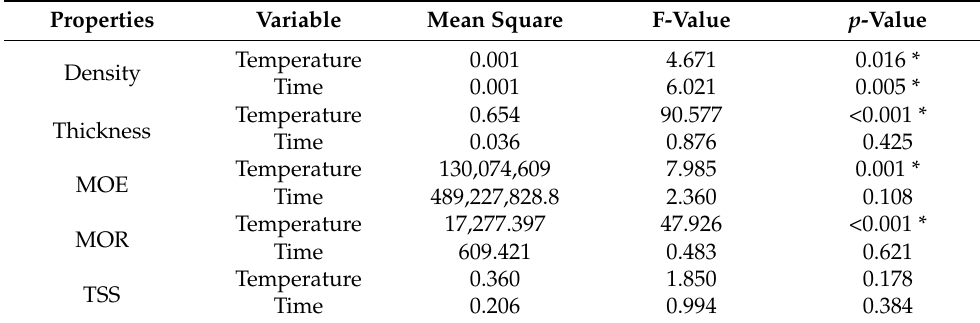
Table 2. Results of statistical significance for one-way